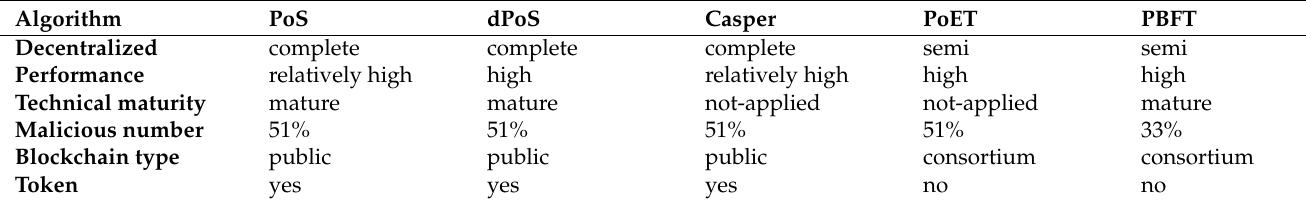
Table 1. Comparison of consensus